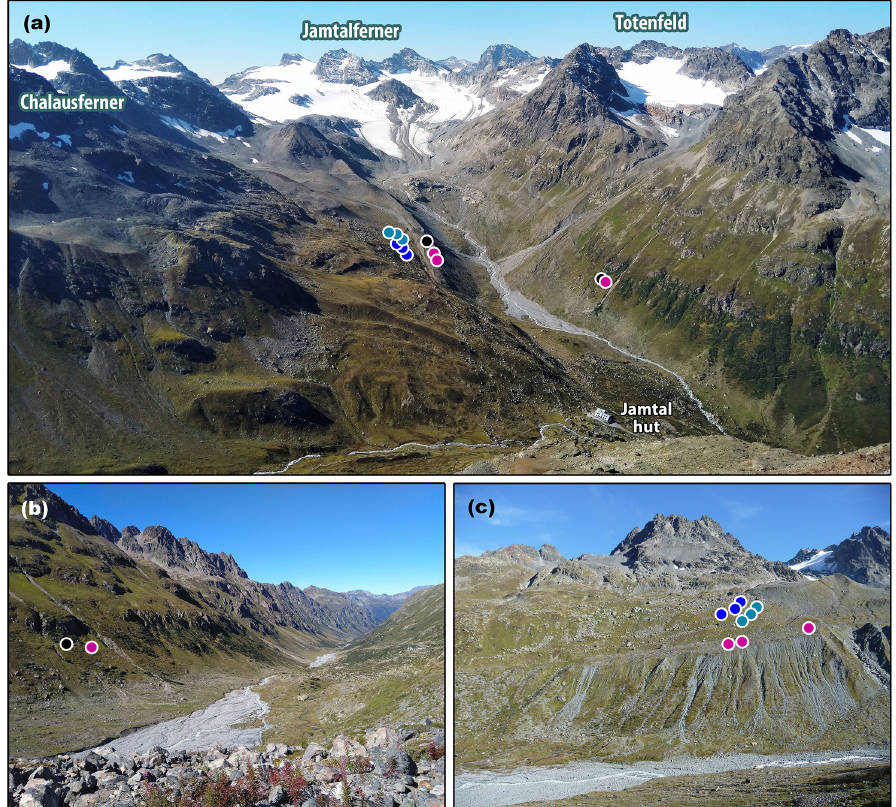
Figure 3. Photographs of Jamtal. (a) View toward Jamtalferner and Totenfeld. 10 Be sample locations are marked with colored circles (pink represents LIA; black represents Neoglacial, cyan and blue represent EH). (b) Down-valley view depicting sample locations JAM-18-06 (pink) and JAM-18-07 (black). (c) Valley flank below Chalausferner and Augustenferner with sampled boulders along the innermost (pink), middle (cyan), and outer (blue) right lateral moraine of former Chaulausferner. For the broader context of the individual sites, see Fig.